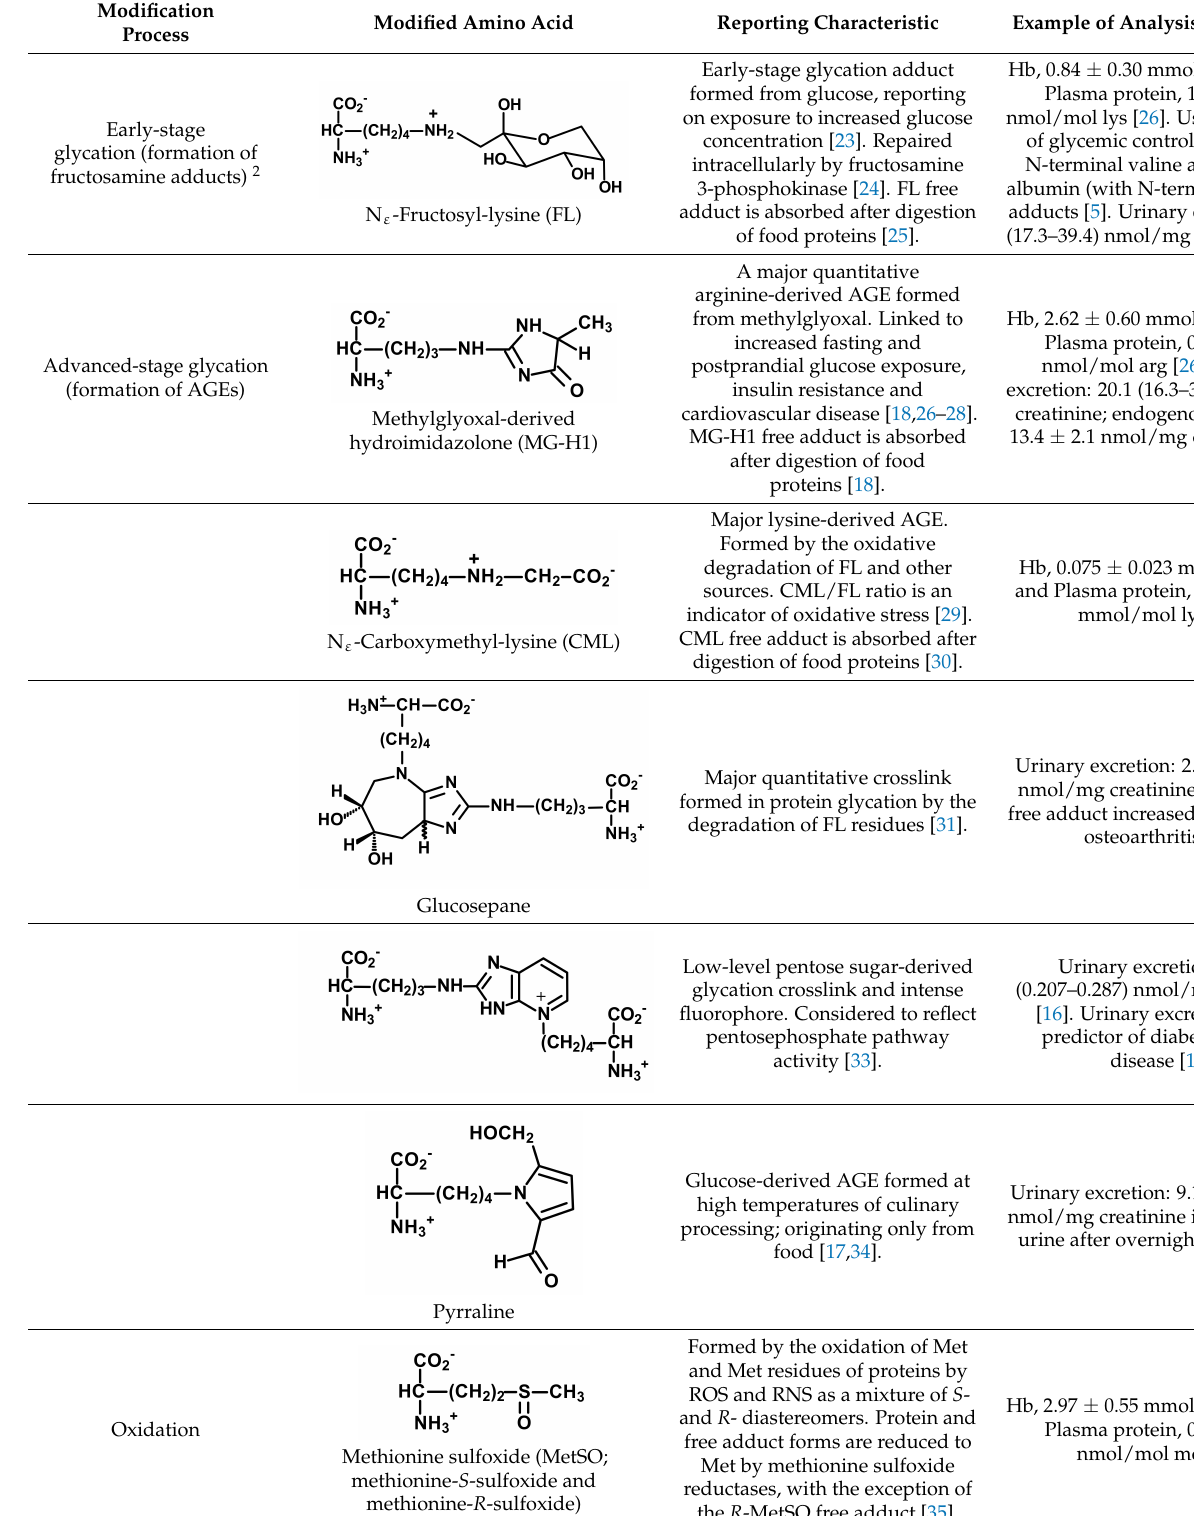
Table 1. Protein glycation, oxidation, nitration and other modification adducts assayed in